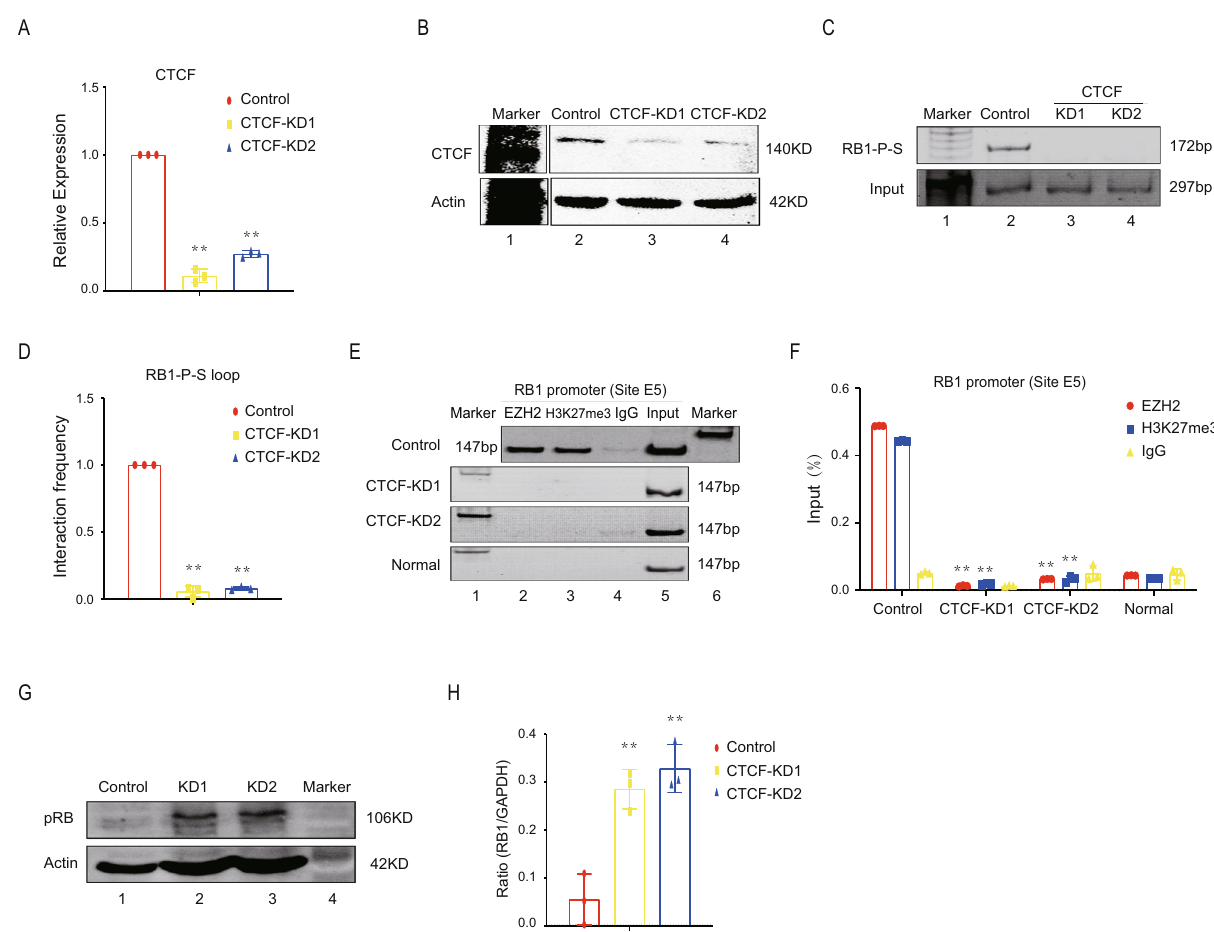
Fig. 4 Silencing of CTCF abolishes the chromosomal looping and reactivates pRB expression. A RT-qPCR of CTCF expression at RNA level after CTCF knockdown with shRNAs transfection. ** P < 0.01. B Western blot was performed to detect CTCF protein expression after shRNA transfection. C , D 3C assay of the existence of chromosomal looping after CTCF knockdown by PCR and qPCR, respectively. ** P < 0.01. E , F ChIP assay of the binding of EZH2 to the RB1 promoter (site E5) and the level of H3K27me3 after CTCF knockdown. ** P < 0.01. G , H Western blot of the expression level of pRB after CTCF knockdown. ** P <